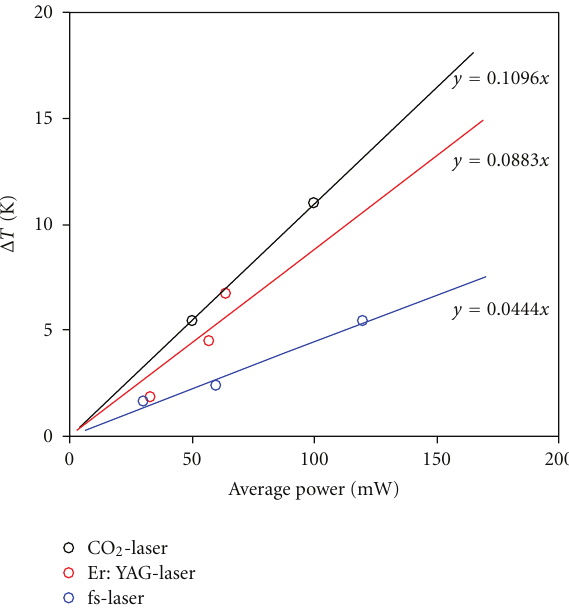
Figure 6: Temperature increases using di ff erent laser systems.